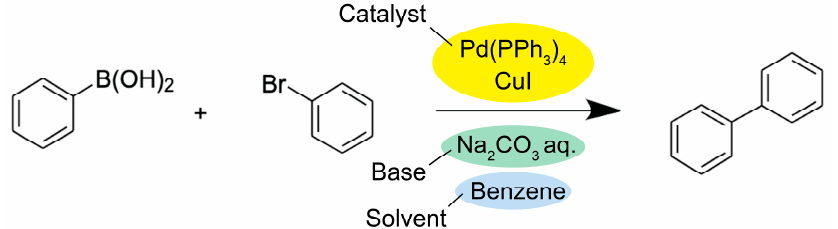
Figure 2. General reaction scheme for the Suzuki coupling reaction [16].